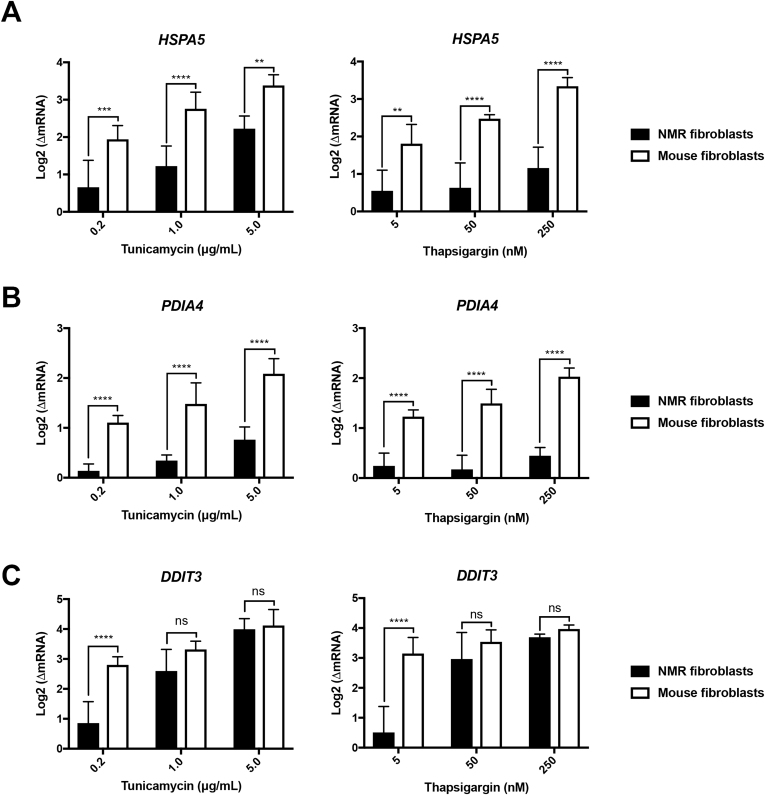
Induction of BiP/Hspa5, ERp72/PDIA4 and CHOP/Ddit3 in the NMR and mouse kidney fibroblasts in response to TU (6 h) and TG (4 h).All results were presented as mean ± S.D. of log-transformed mRNA fold change compared to the basal-level expression in untreated cells. n = 5 pairs; ns, P > 0.5, ∗∗P < 0.01, ∗∗∗P < 0.001, ∗∗∗∗P < 0.0001; two-way ANOVA tests, Sidak’s multiple comparisons tests.